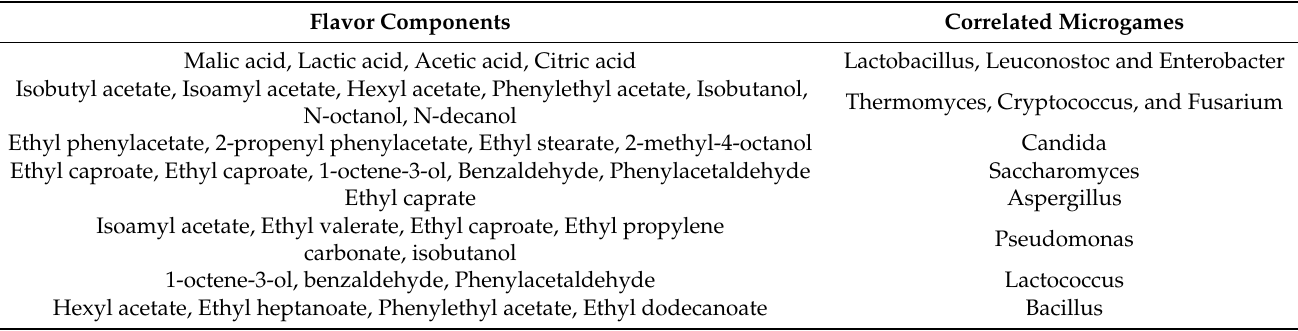
Table 5. Flavor components in HL and correlated microgames in HL fermentation